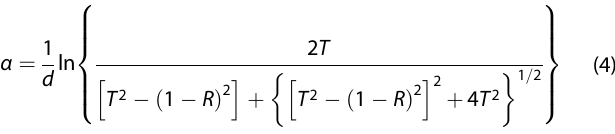
Figure 5d plots the dependence of the THG emission power from the 44 nm-thick lengenbachite crystal as function of incident linear polarization angle with respect to x -axis for fundamental beam power at 1.1 mW. The desired linear polarization of the along x -axis ( c -axis of the crystal) and a rotating half-wave plate. The black, red and blue data points represent the measured x- component , y- component and total THG power, while the solid curves are theoretical fi ts using Eq. (6), which agree well with the experimental data. It is clear that the polarization-dependent THG emission from the lengenbachite crystal displays an anisotropic two-fold symmetric pattern, with the maximum THG power at 0° as the incident linear polarization is parallel to the